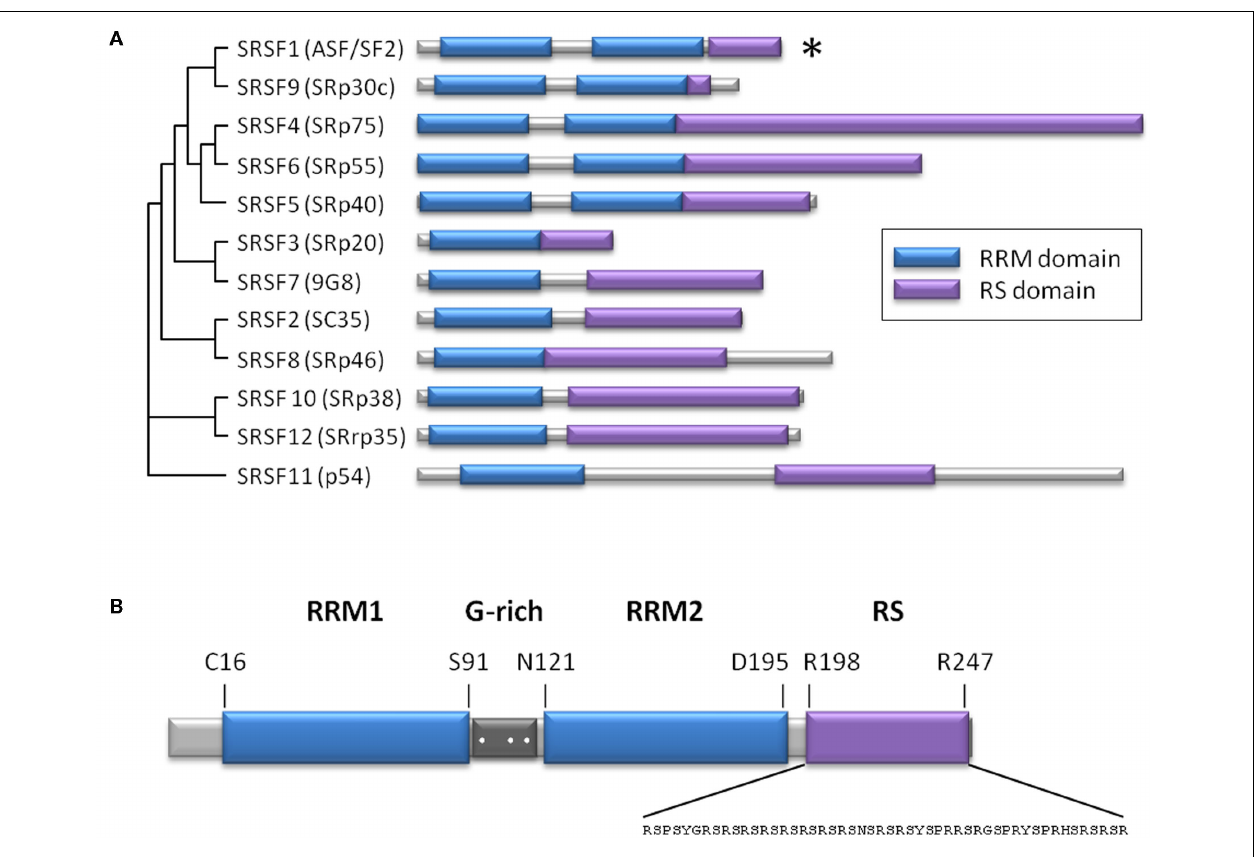
heterologous RNA-binding domain and be still functional.The asterisk indicates the SRSF1 member. (B) Structural scheme of SRSF1 showing two RRM domains (blue) separated by a glycine-rich sequence (dark gray), where three arginine residues are susceptible to methylation (white dots).The sequence of the RS domain (violet) is indicated. RRM, RNA recognition motif; RS, arginine/serine-rich.